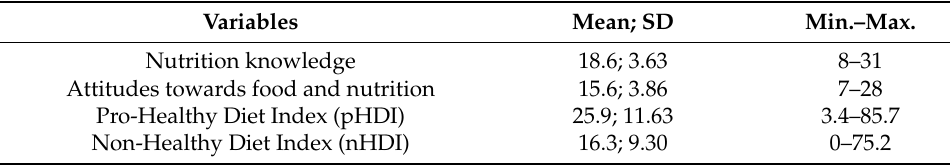
Table 3. Participants’ nutrition knowledge, attitudes, and diet indices.